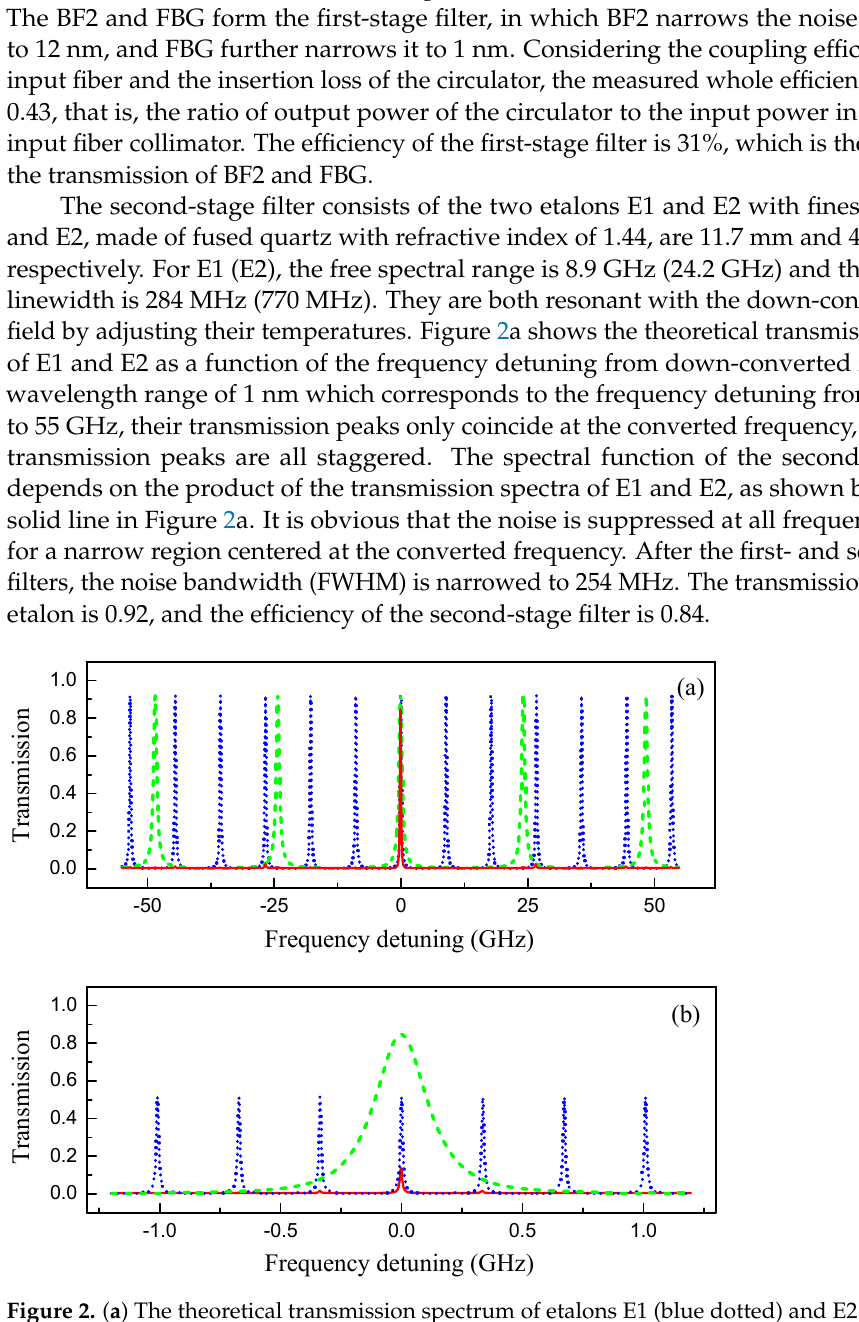
Figure 2. ( a ) The theoretical transmission spectrum of etalons E1 (blue dotted) and E2 (green dash). The red solid line represents the spectral function of the second-stage filter. ( b ) The spectral function of the F-P cavity (blue dotted) and the second-stage filter (green dash). The red solid line represents the spectral function of the three-stage filtering system.